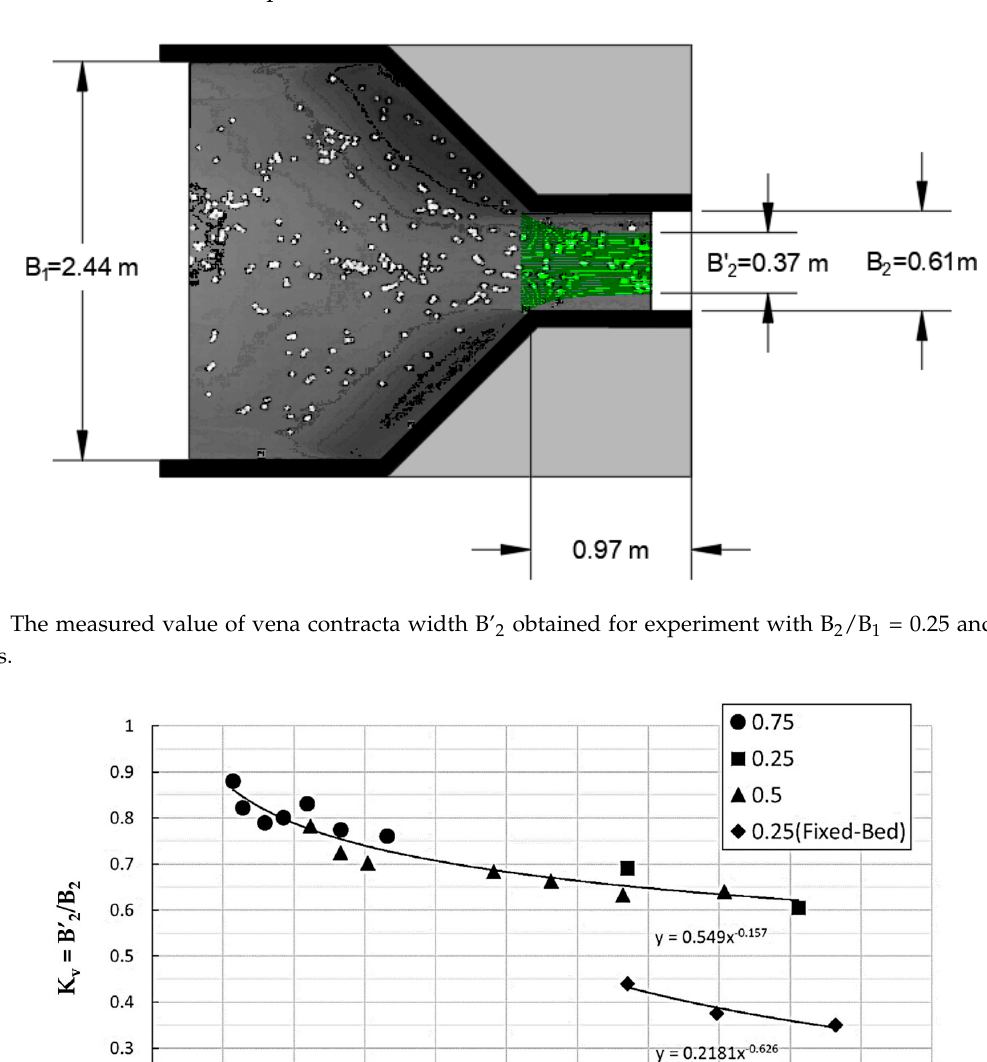
Figure 19. The measured value of vena contracta width B’ 2 obtained for experiment with B 2 /B 1 = 0.75 and discharge of 0.099 m 3 /s.